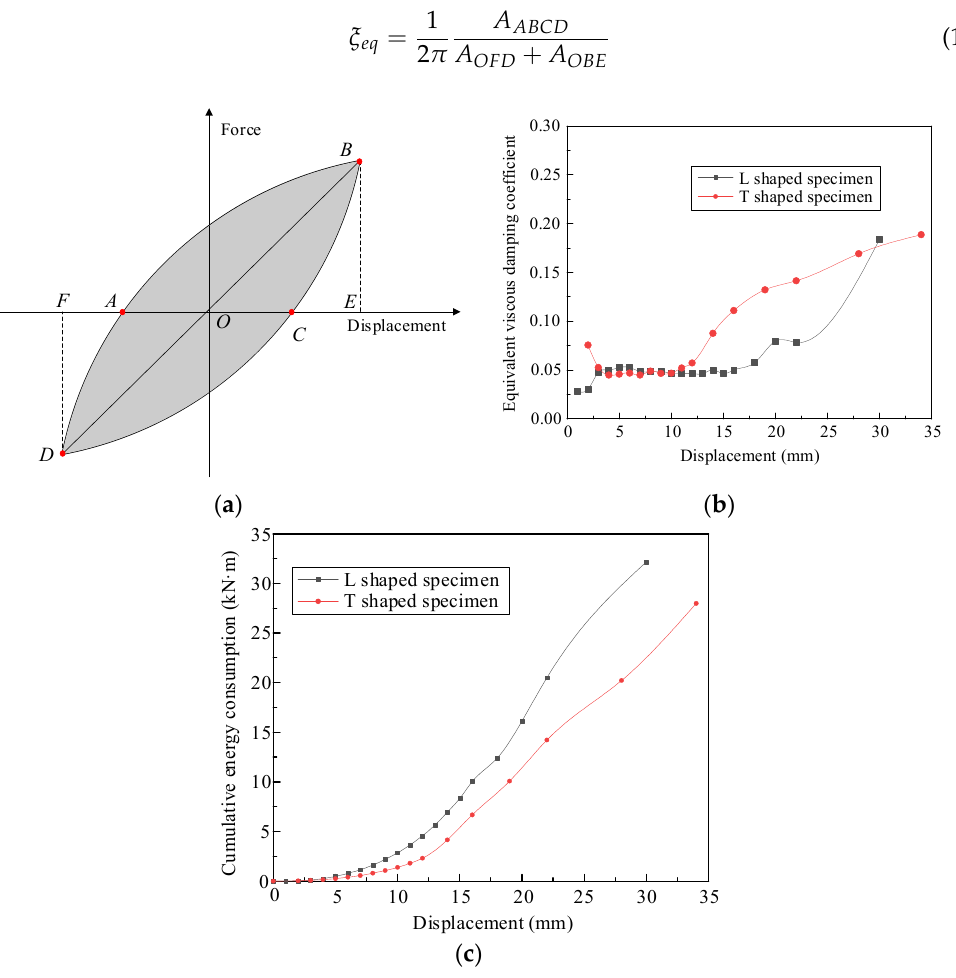
Figure 14. Specimen energy dissipation index. ( a ) Typical hysteresis loop; ( b ) equivalent viscous damping coefficient; ( c ) cumulative hysteresis energy consumption.